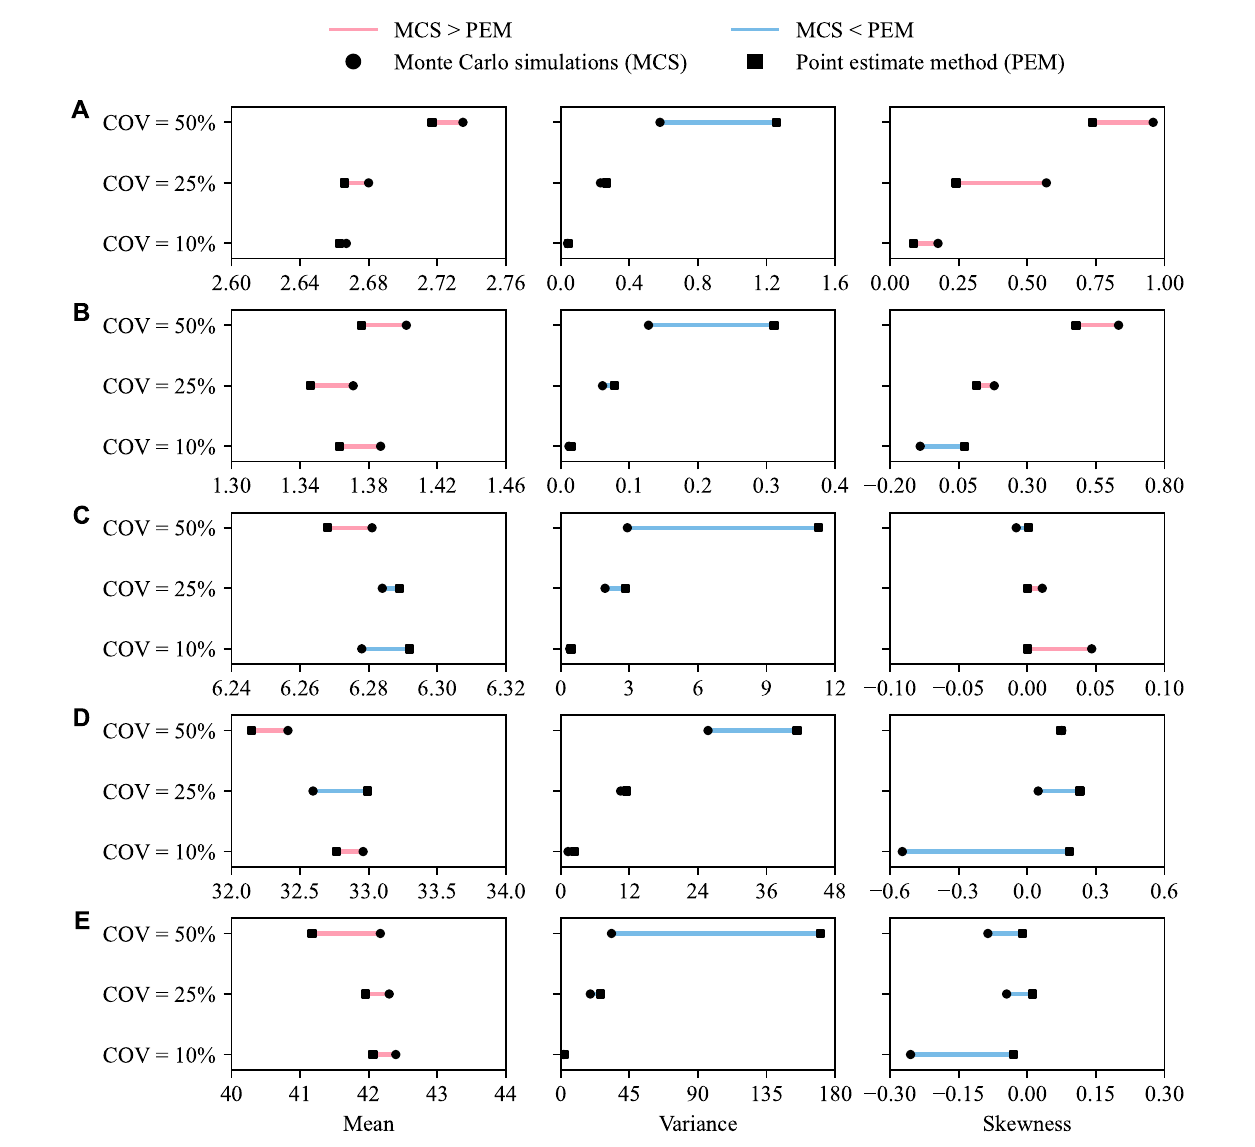
FIGURE 4 Three moments (mean, variance and skewness) of (A) impact area (in x10 6 m 2 ), (B) deposit area (in x10 6 m 2 ), (C) deposit volume (in x10 6 m 3 ), (D) maximum flow velocity (in m/s) and (E) maximum flow height (in m) at ( x , y ) = (1490100, 5204100) obtained from Acheron rock avalanche with Monte Carlo simulations (MCS) and point estimate method